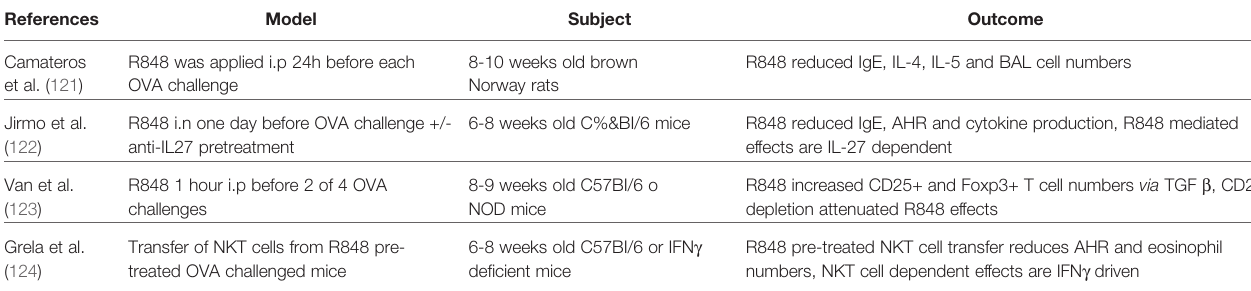
TABLE 1 | Overview of important literature on the use of resiquimod (R848) as therapeutic agent in animal models of